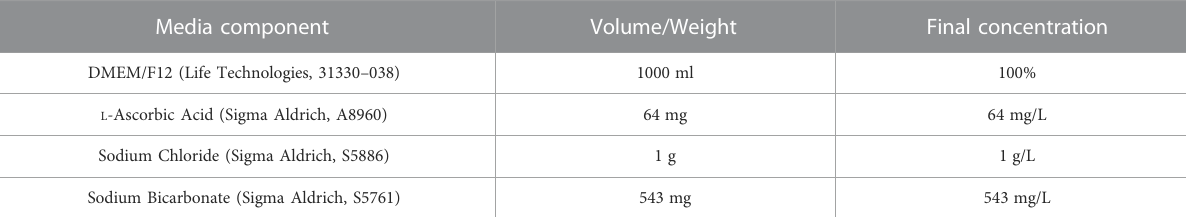
TABLE 1 Components of E6 base media. Media